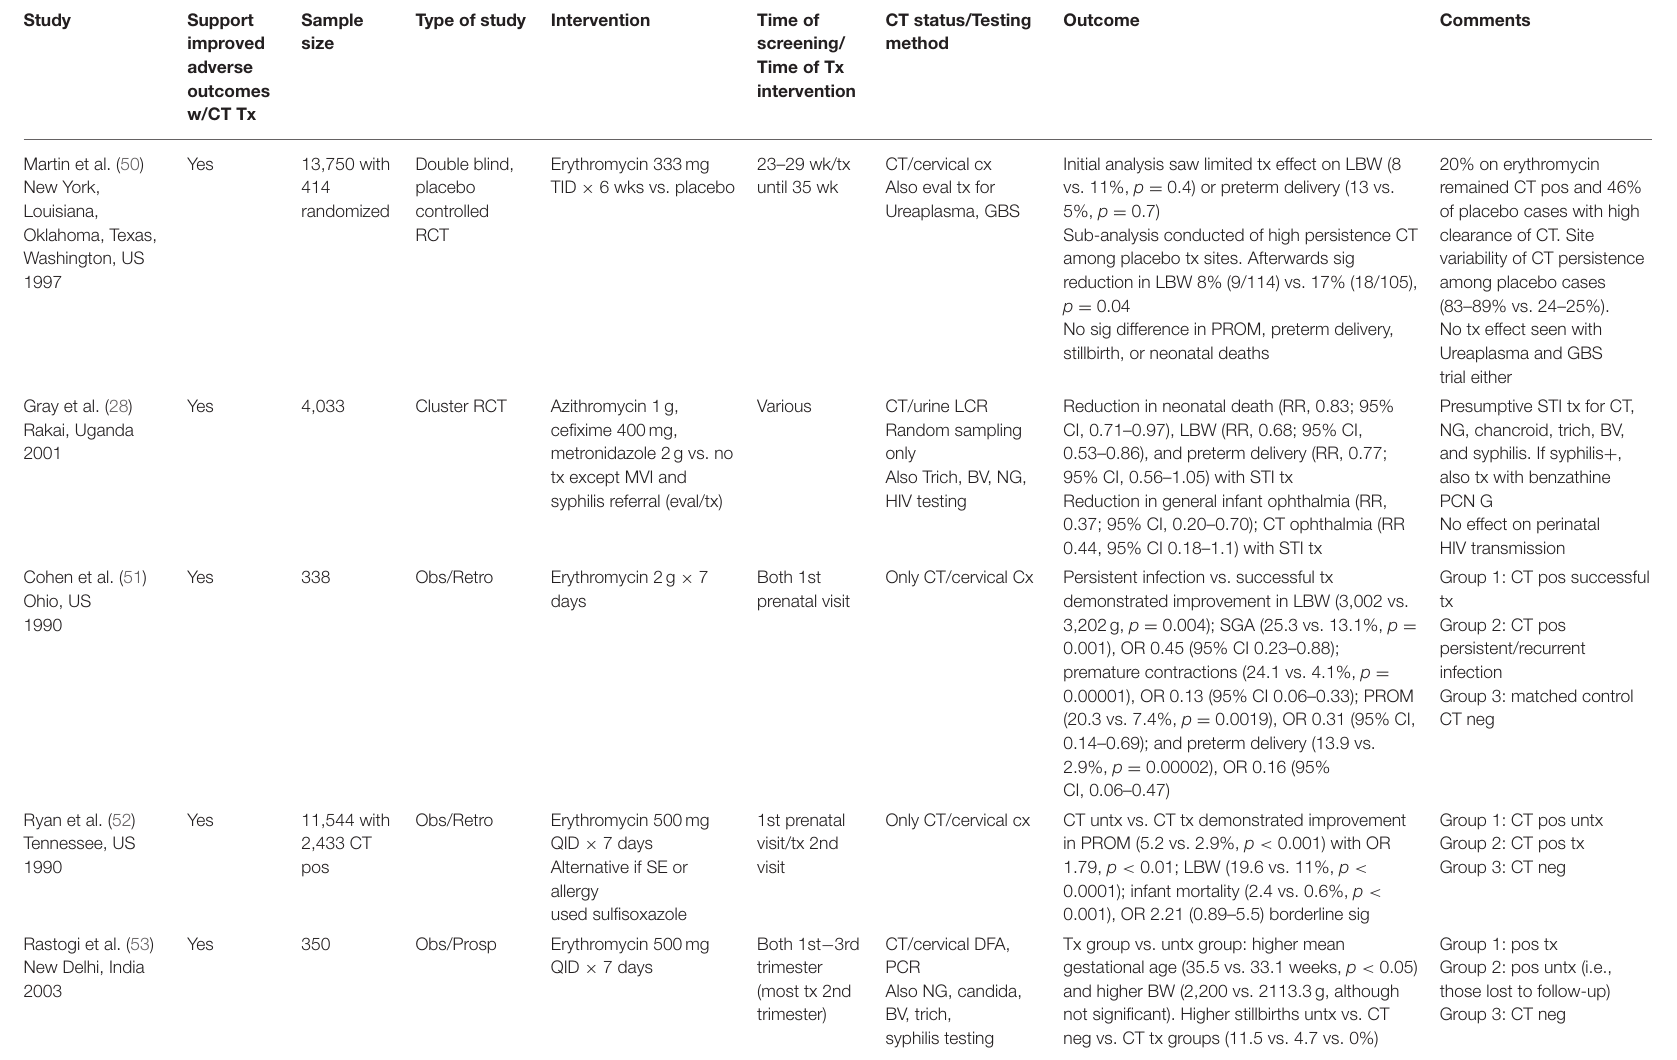
TABLE 1 | Prevention of adverse pregnancy outcomes with antenatal chlamydial treatment (total studies N =